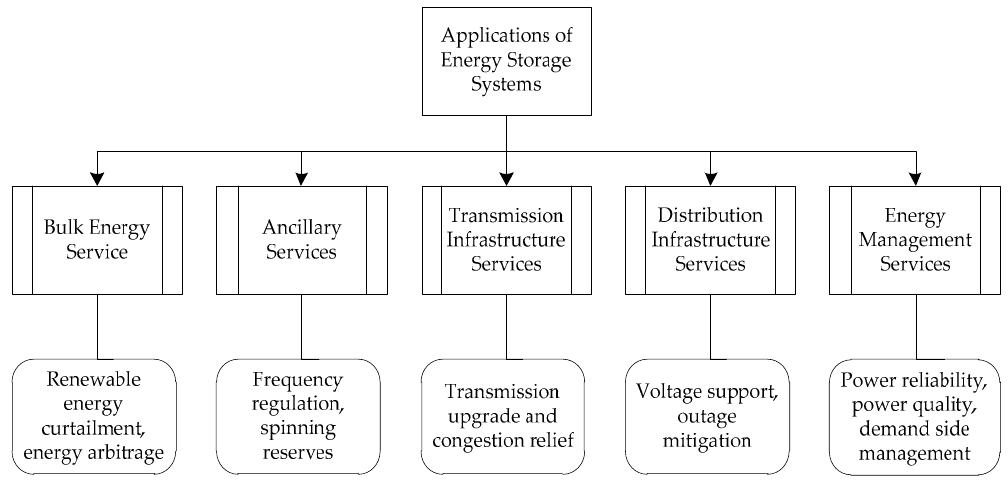
Figure 5. Applications of energy storage systems.